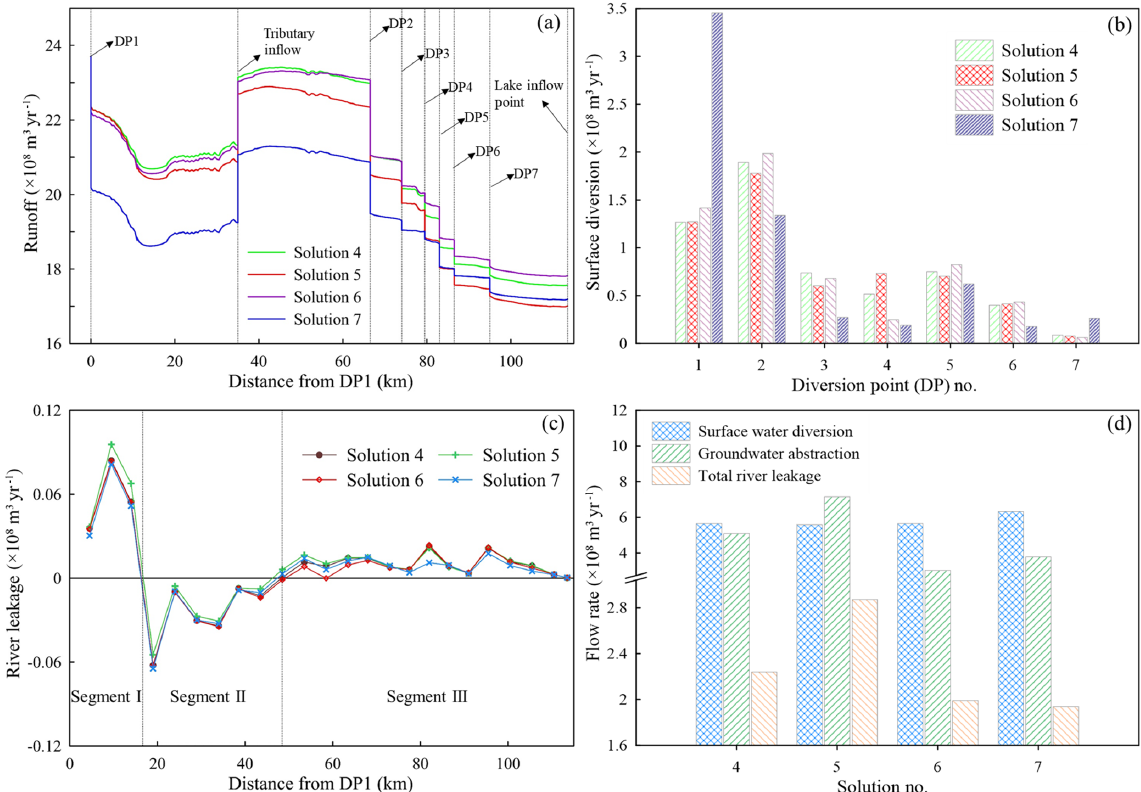
Figure 10. Variation of surface runoff and river leakage along the stem stream of the Kaidu River: (a) the profile of river runoff; (b) the distribution of surface water diversion at the different diversion points; (c) the profile of river leakage; (d) the components of total river leakage, groundwater abstraction, and surface water diversion for several typical solutions